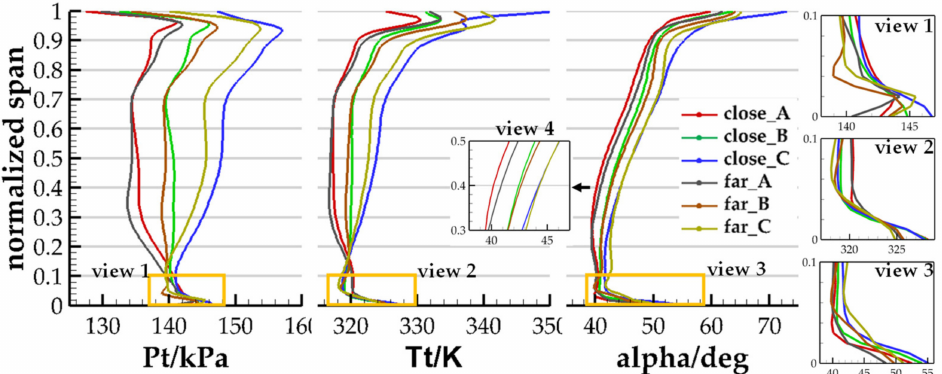
Figure 11. Radial distribution of the time-averaged stator inlet parameters.